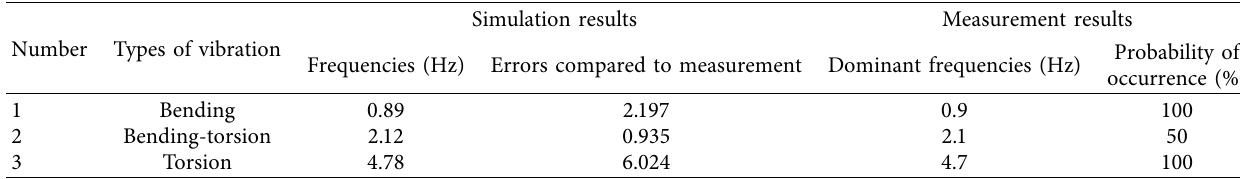
Table 9: Frequency of occurrence of frequencies on Phu My cable-stayed bridge (obtained from LAM).